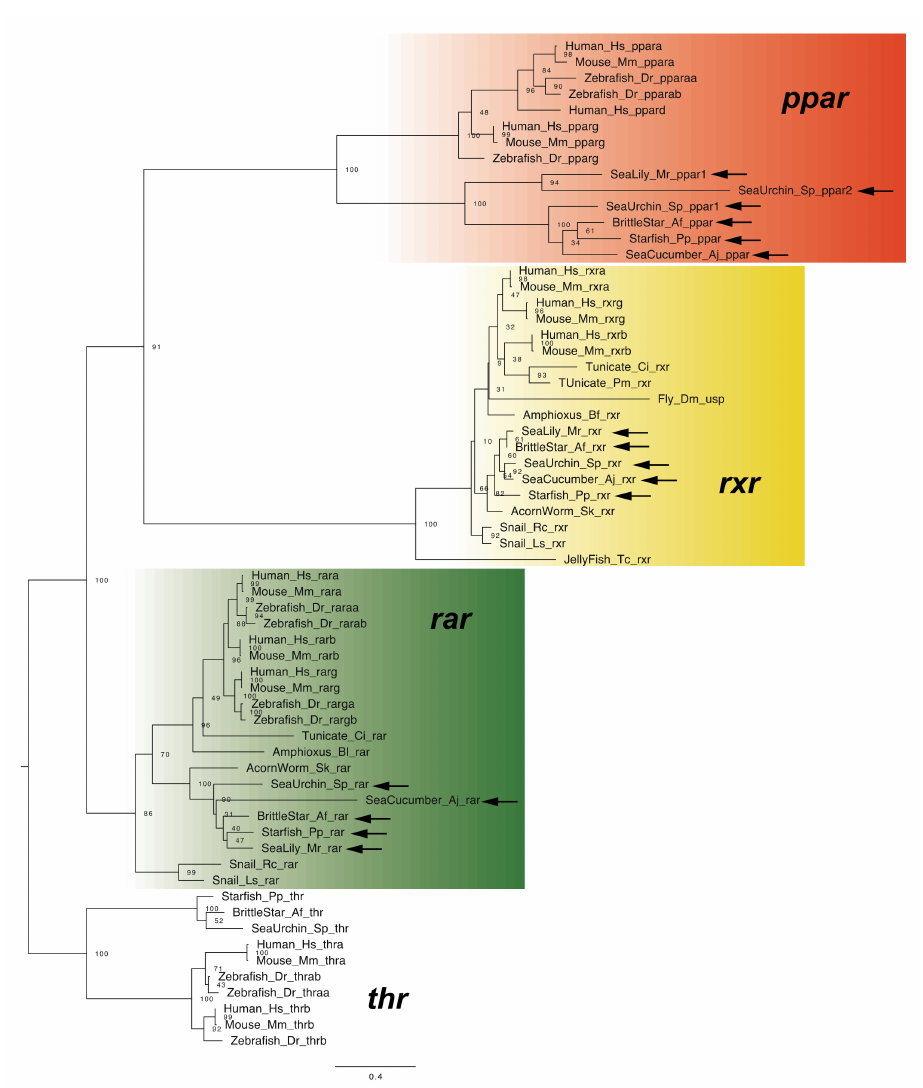
Figure 7. Maximum-likelihood phylogenetic tree for nuclear receptor genes. We retrieved the dataset of nuclear receptor genes (Table S7, Supplementary Dataset 7) and constructed phylogenetic tree as described above. Each color box indicates the gene clade of ppar ( orange ), rar ( green ) and rxr ( yellow ). Arrows indicate the genes retrieved from dataset of echinoderms. Abbreviation: thr ; thyroid hormone receptor , Amphioxus (Bl); Branchiostoma lanceolatum , Tunicate (Pm); Polyandrocarpa misakiensis , Snail (Rc); Reishia clavigera , Snail (Ls); Lymnaea stagnalis and Jellyfish; Tripedalia cystophora